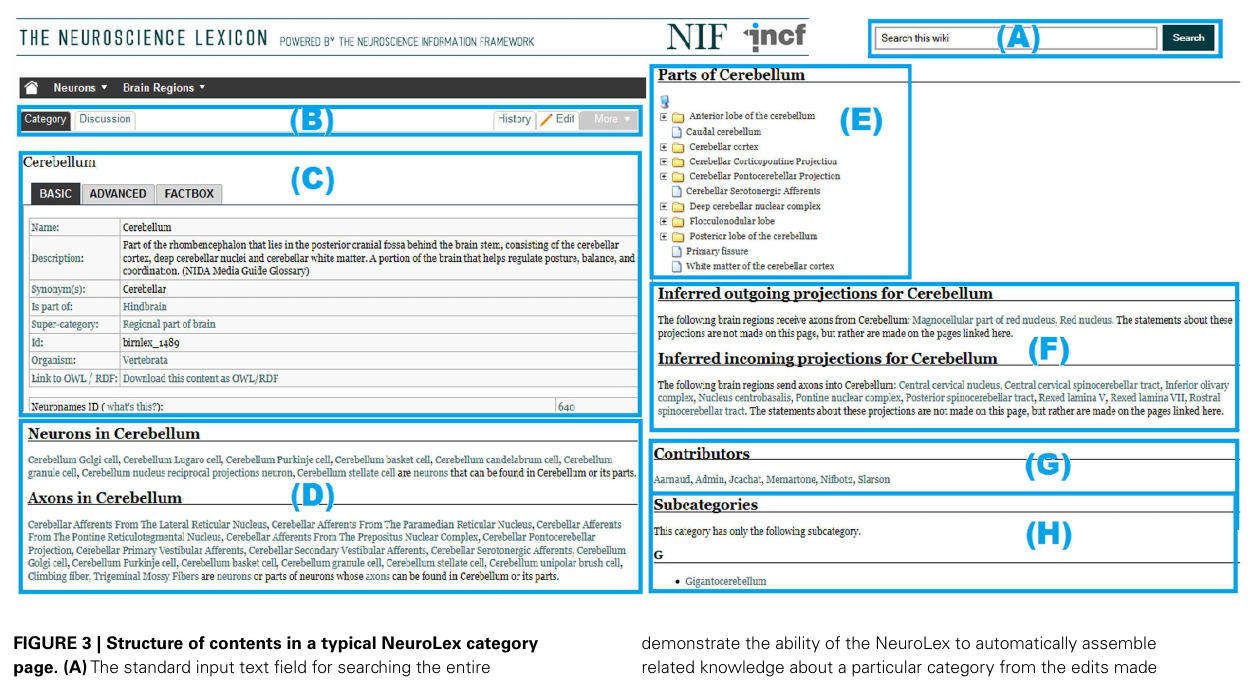
FIGURE 3 | Structure of contents in a typical NeuroLex category page. (A) The standard input text field for searching the entire NeuroLex wiki contents. (B) Different tabs to display and edit the contents of a particular category page. (C) The structured contents of a category page (e.g., Cerebellum). Boxes corresponding to (D–F)